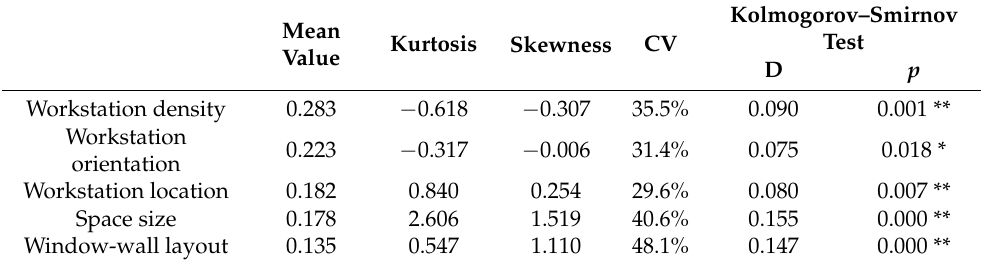
Table 6. Distribution statistics of importance weights in